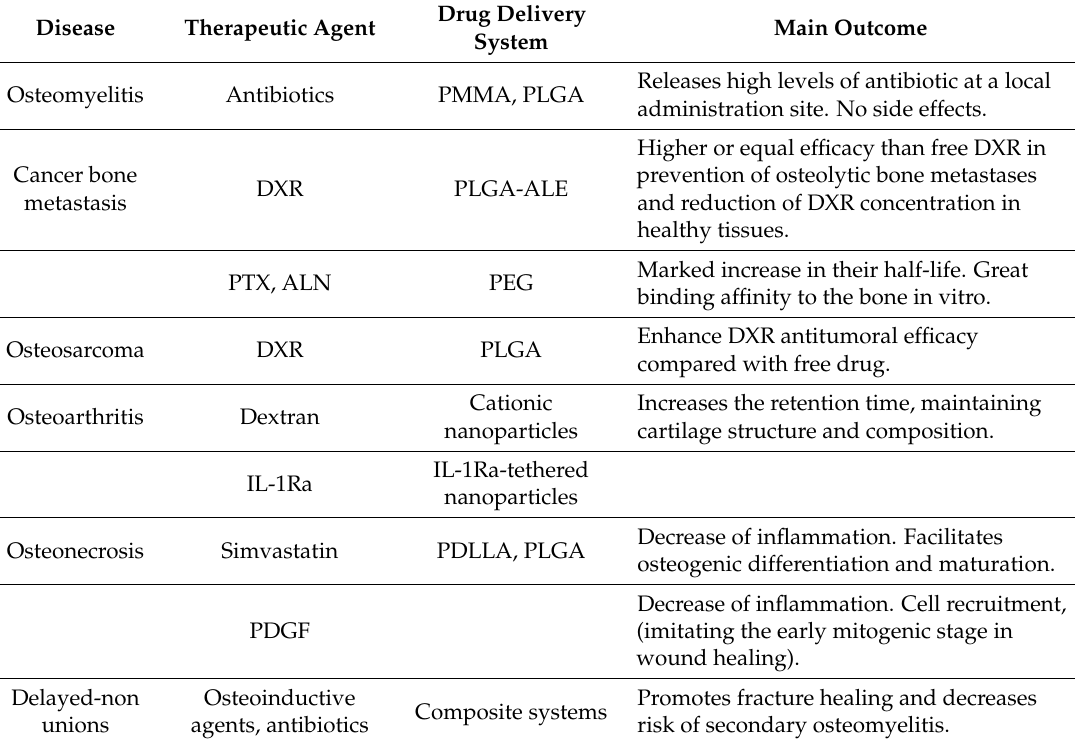
Table 1. Clinical applications in drug